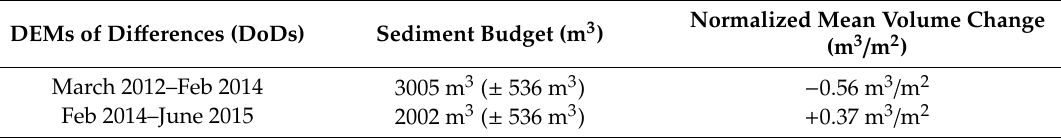
Figure 7. Use of orthophotographs and DoDs to study the impact of the storms (winter 2013–2014). Comparison of the orthophotographs in March 2012 ( a ), February 2014 ( b ), and June 2015 ( c ). DEM of differences computed over the periods from March 2012 to February 2014 ( d ), February 2014 to June 2015 ( e ), and March 2012 to June 2015 ( f ). Table 2. Pairwise differential sediment balance and normalized mean volume change.